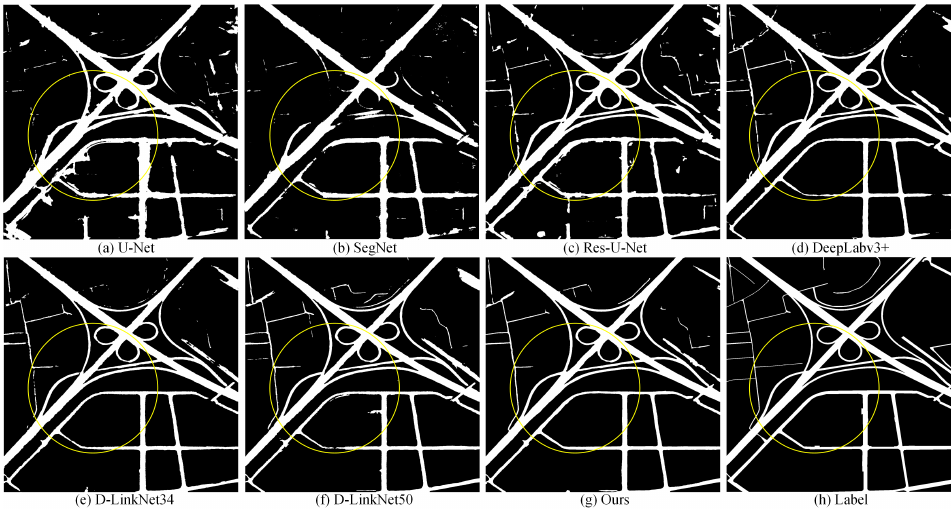
Figure 13. Extracted samples for related methods on the Huawei